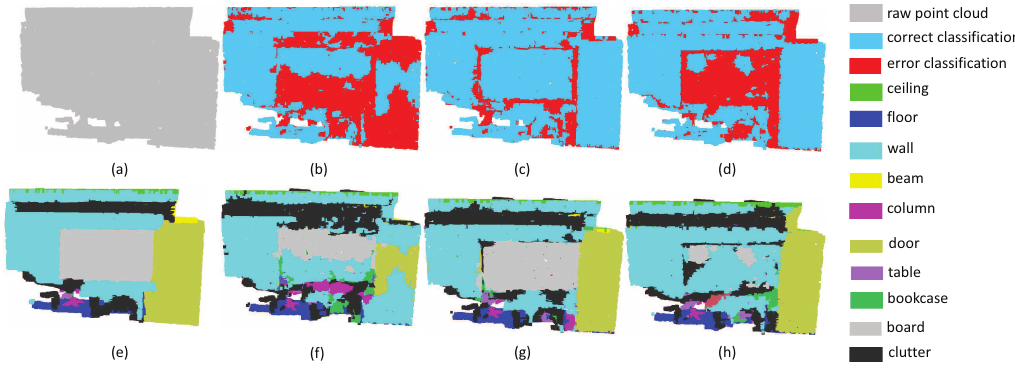
Figure 19. The segmentation results on PantryS 3 D . ( a ) input, ( e ) ground truth, ( b , f ) the classification result by PointNet++, ( c , g ) the classification result by PointSIFT, and ( d , h ) the classification result by SAN.